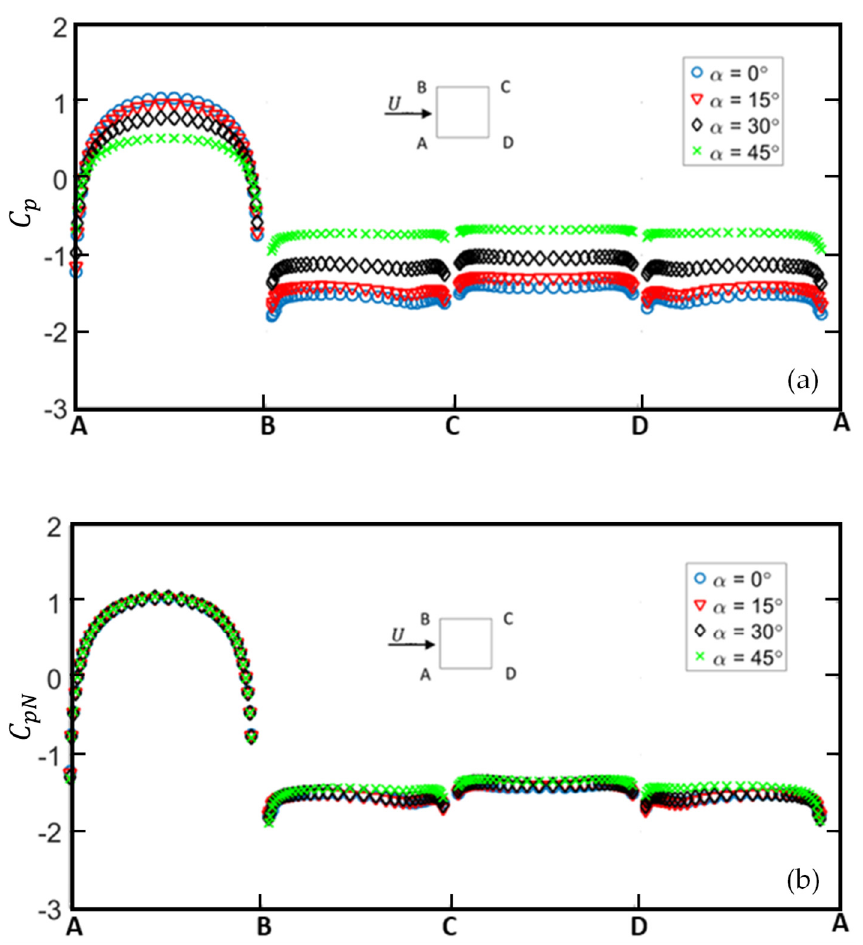
Figure 8. Distributions and comparison with previous studies of the time-averaged pressure coeffi- cient on the cylinder surfaces for α = 0°.  : Present study, Re = 1000;  : Norberg [35], Re = 5000;  : Sohankar et al. [16], Re = 500.